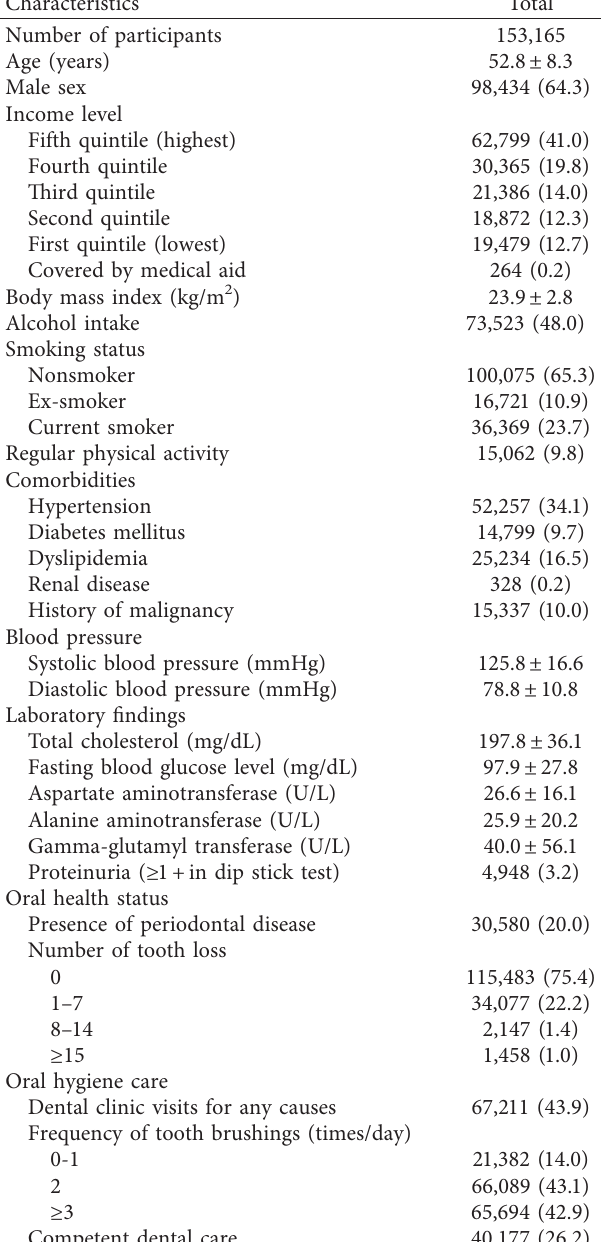
Table 1: Baseline characteristics of the study